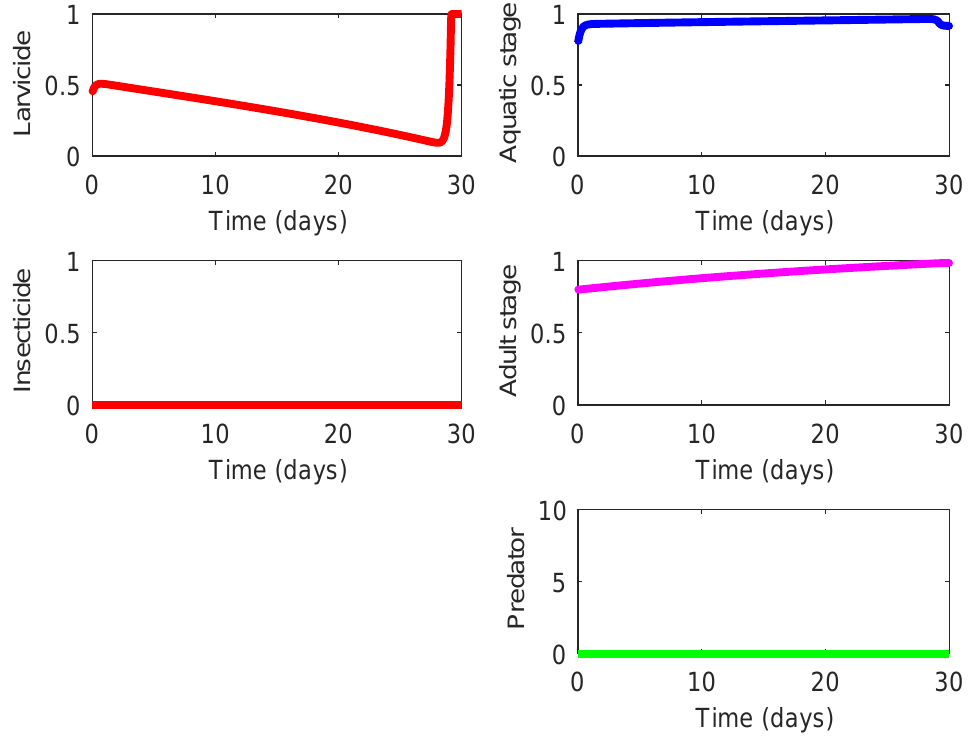
Figure 4. State and control profiles of the system (1) under Strategy 001: application of low-lethality larvicide in the absence of the predacious